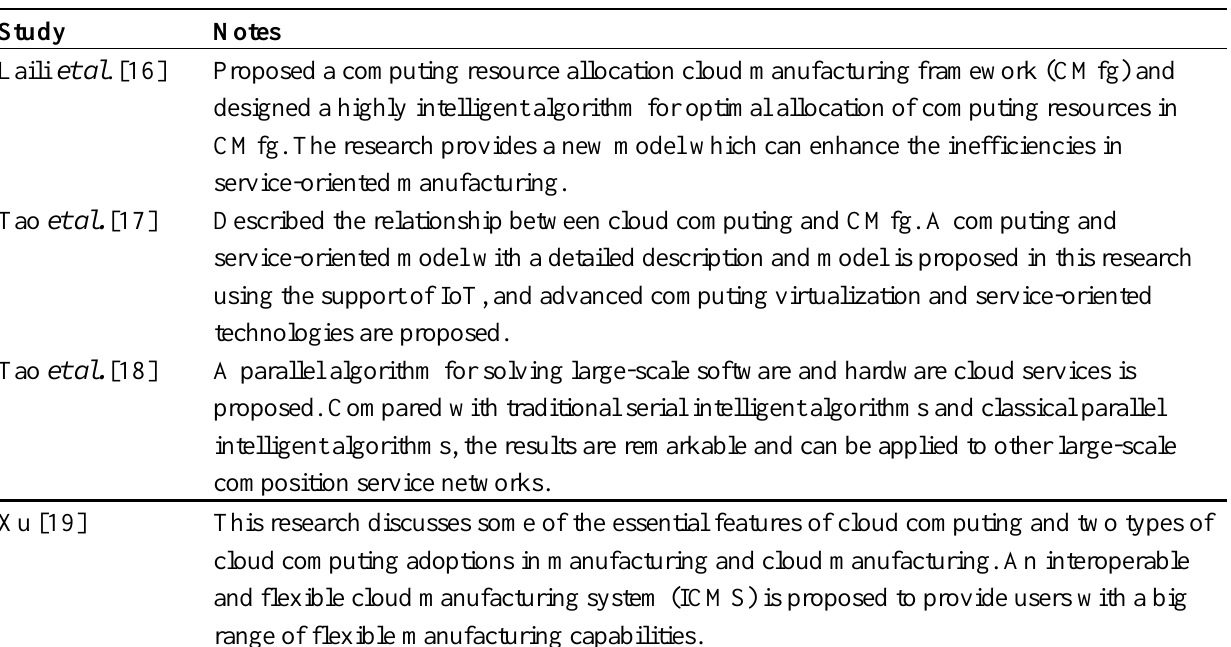
Table 2. Summary of cloud manufacturing previous